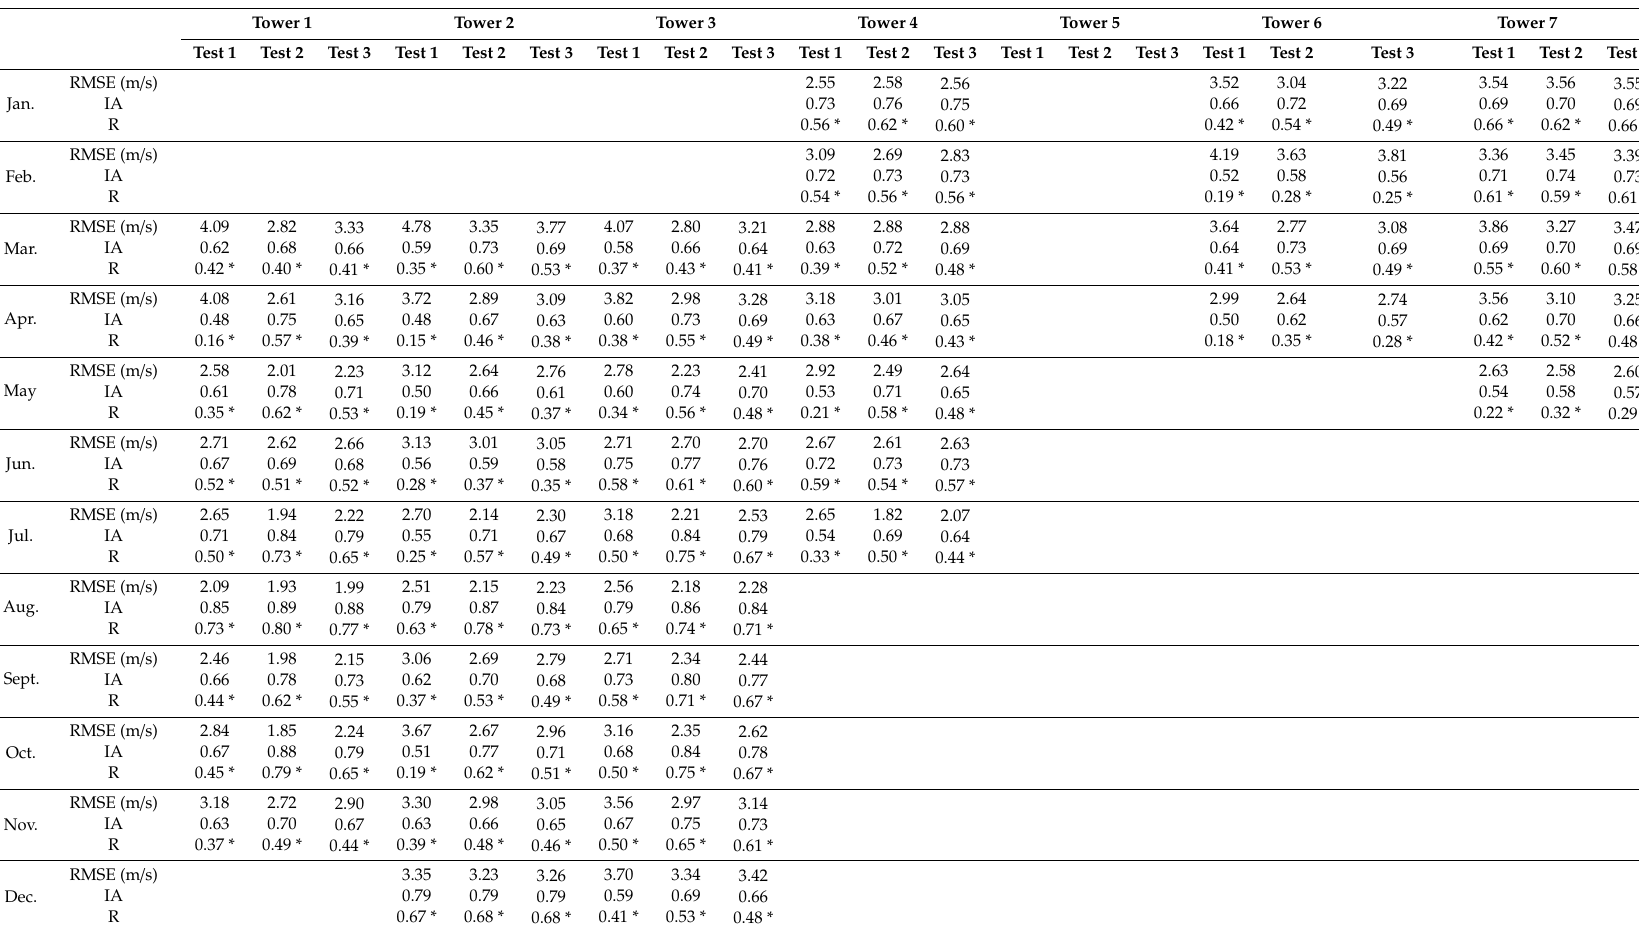
Table A3. Statistical results of Test 1, Test 2, and Test 3, at 70 m